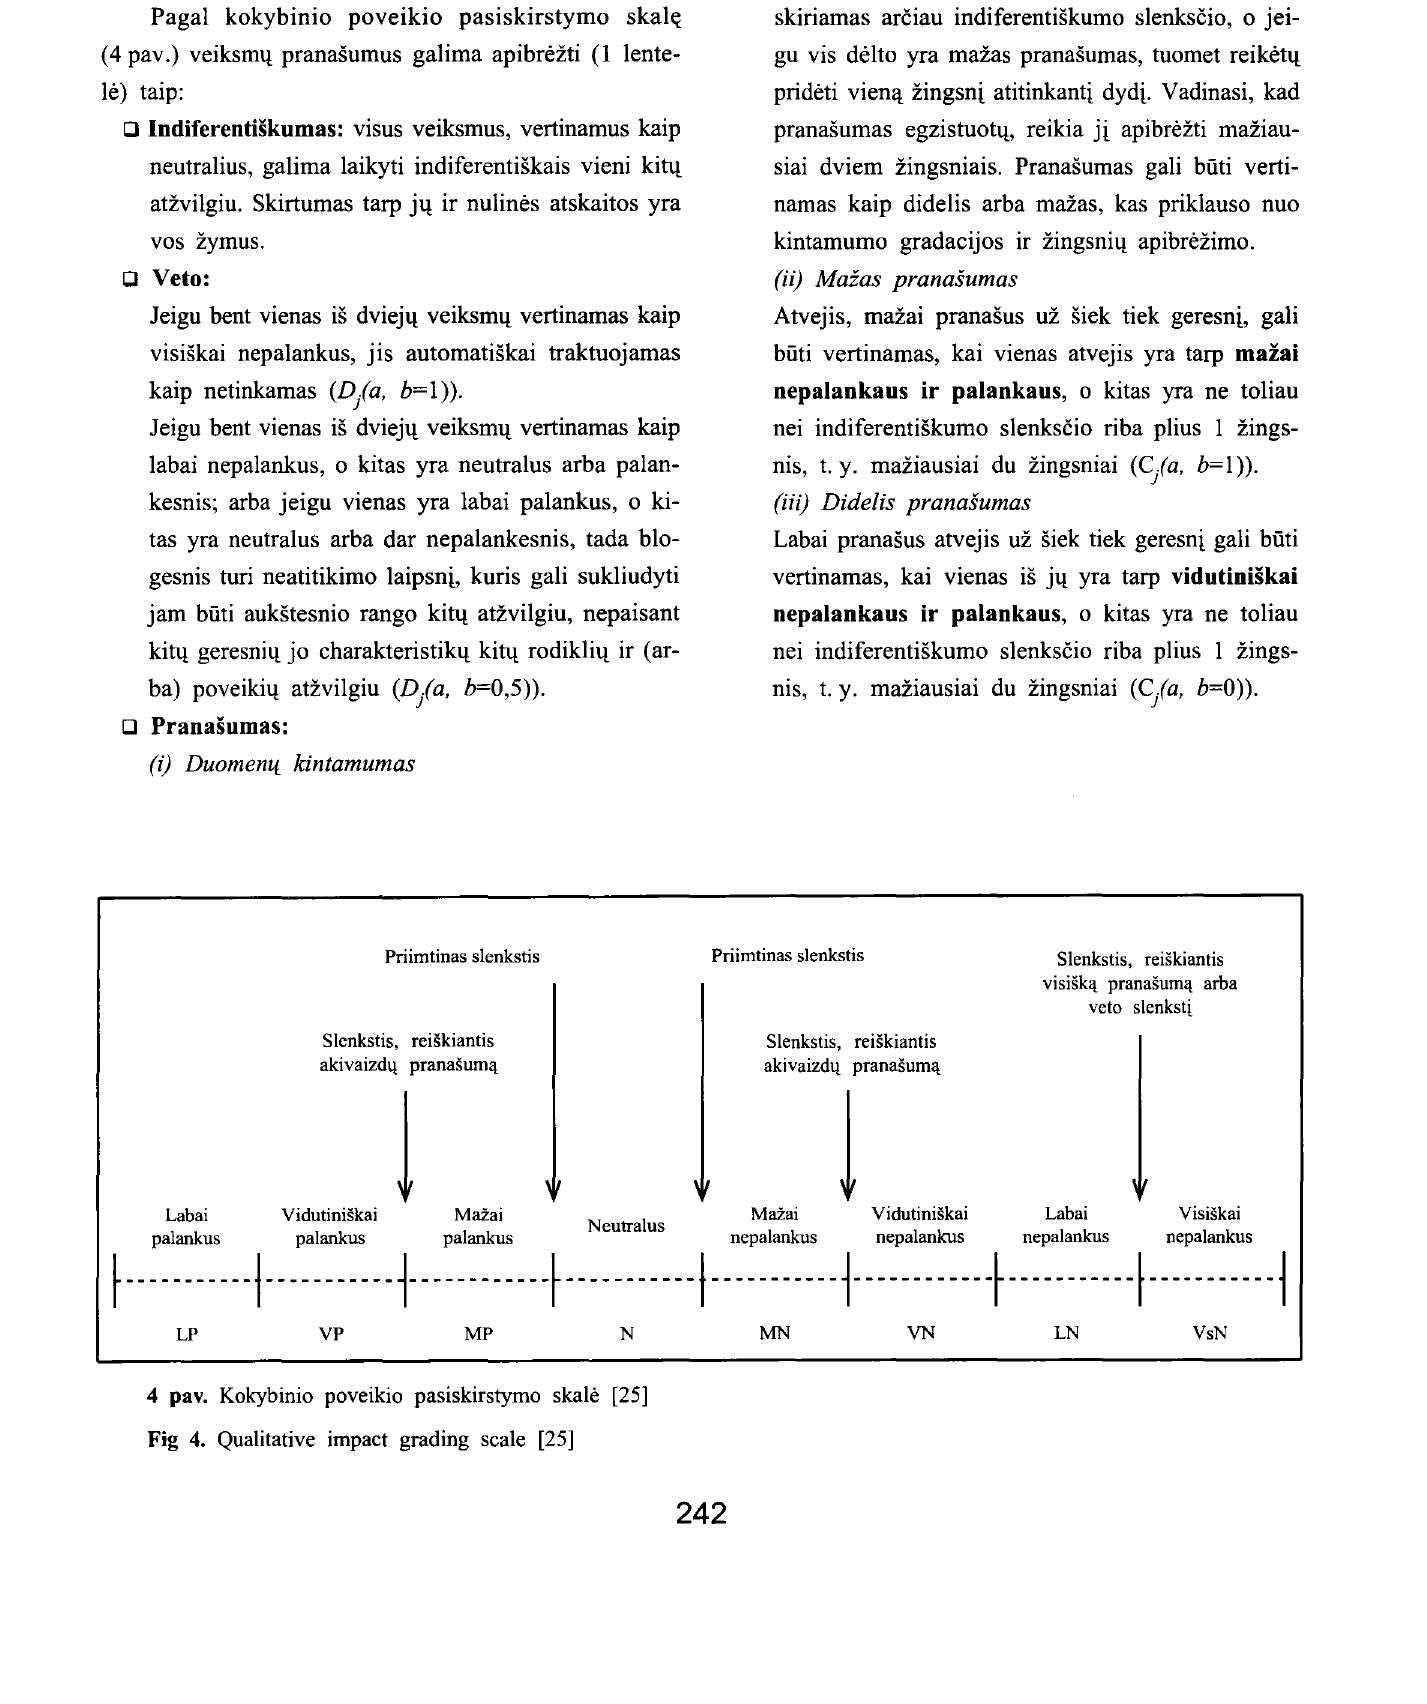
Fig 4. Qualitative impact grading scale